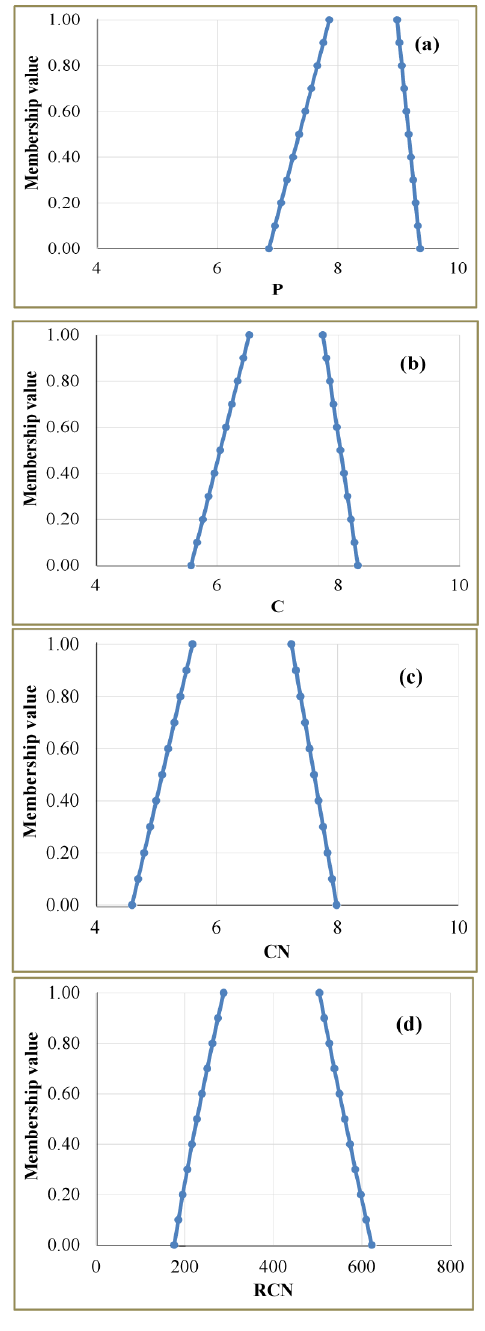
Fig. 6. Fuzzy numbers of risk parameters for the risk event of “Increase in tar price” for (a) P; (b) C; (c) CN and (d)